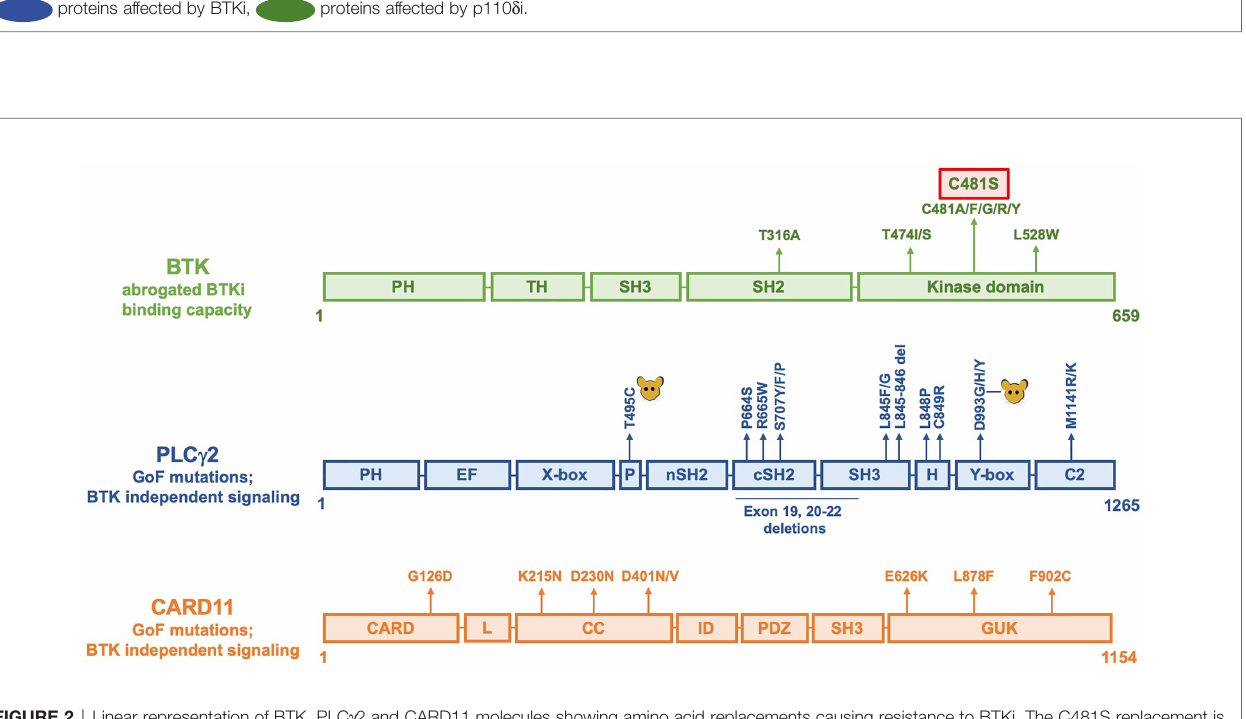
FIGURE 2 | Linear representation of BTK, PLC g 2 and CARD11 molecules showing amino acid replacements causing resistance to BTKi. The C481S replacement is the most common alteration and is marked with a red box. In PLC g 2, alterations induced by mutagenesis in mice are indicated as . Not all reported alterations are listed, only recurrent mutations have been